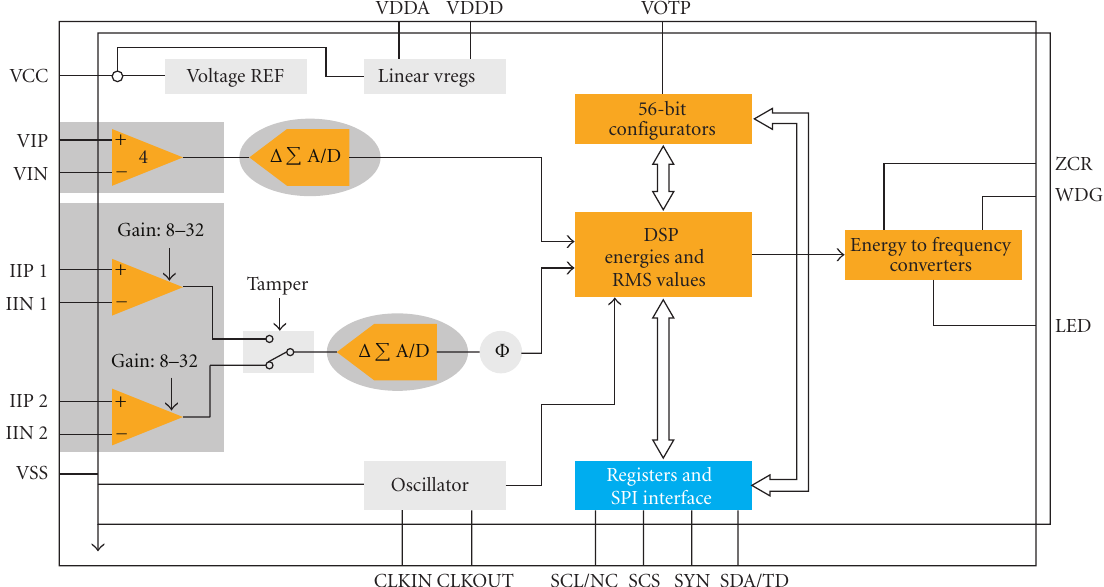
Figure 14: Architecture of the E-meter ASIC [25].